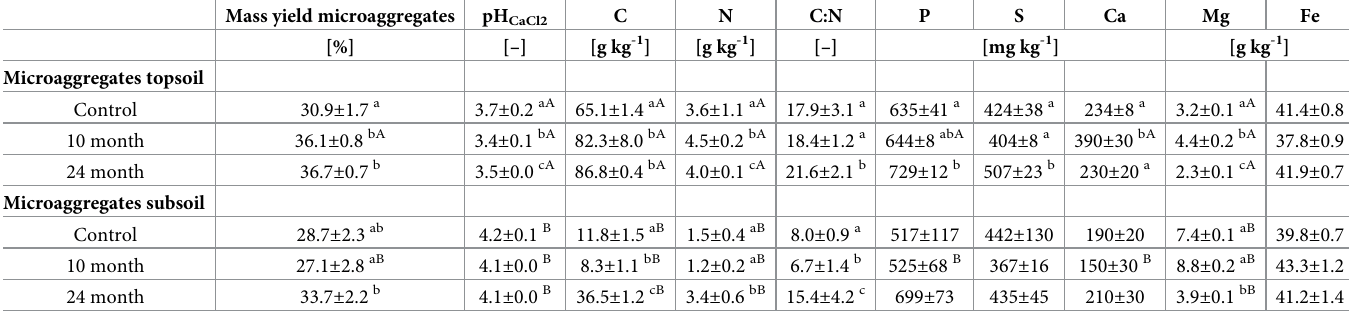
Table 2. Soil microaggregate pH CaCl2 values and elemental composition of pooled samples without clear-cut (control) given as mean ± standard deviation (SD) (n = 3). Total C and N concentrations were determined by dry total combustion, all other total elemental concentrations were determined by microwave-assisted digestion in aqua regia . Different lowercase letters indicate significant ( P < 0 . 05 ) differences with time for microaggregate samples, respectively, whereas different uppercase letters indicate significant differences of microaggregate samples at the respective sampling